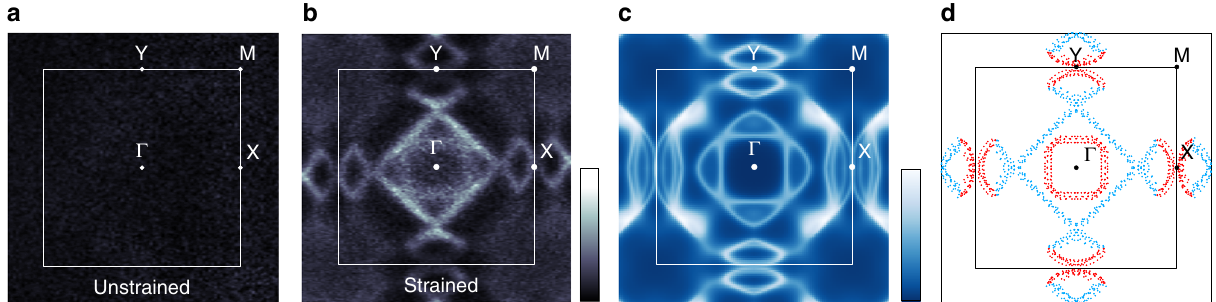
Fig. 2 Strain-induced metallic state of Ca 2 − x Pr x RuO 4 . a , b ARPES Fermi surface maps for a Ca 2 − x Pr x RuO 4 sample with x = 0.07 and a fully strained x = 0.04 sample measured at 50 K and 8 K, respectively. The former was measured on a suf fi ciently thick sample to cause almost complete relaxation of the initial strain. The data were acquired using 64 eV photons with linear horizontal polarization. Light colors correspond to high intensities. c Dynamical mean fi eld theory (DMFT) calculation of the Fermi surface. For details, see methods. Light colors correspond to high intensities. d Fermi surface contours extracted from the data in b . Contours originating predominantly from the quasi-1D xz / yz orbitals and the in-plane xy orbital are colored in light blue and red,